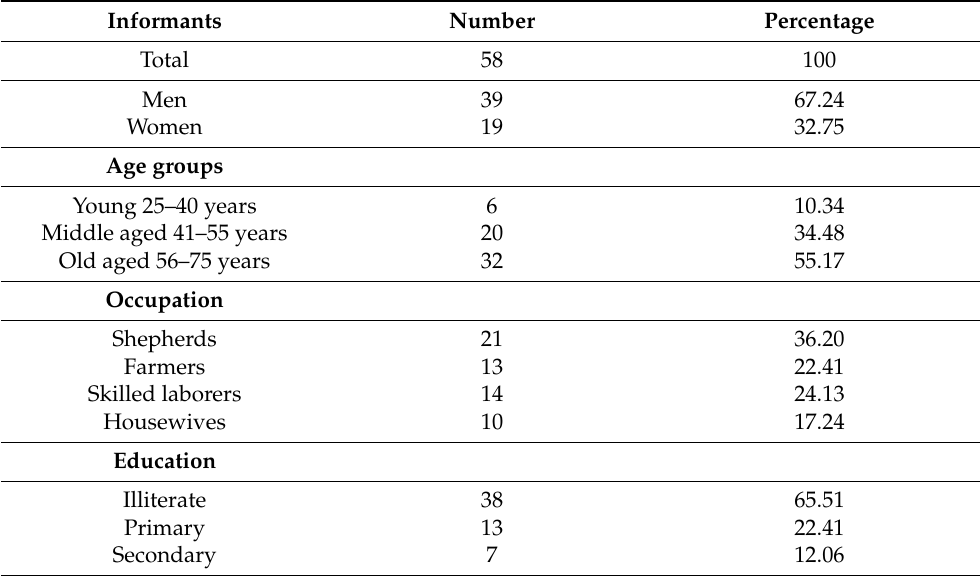
Table 1. Demography of informants from the study